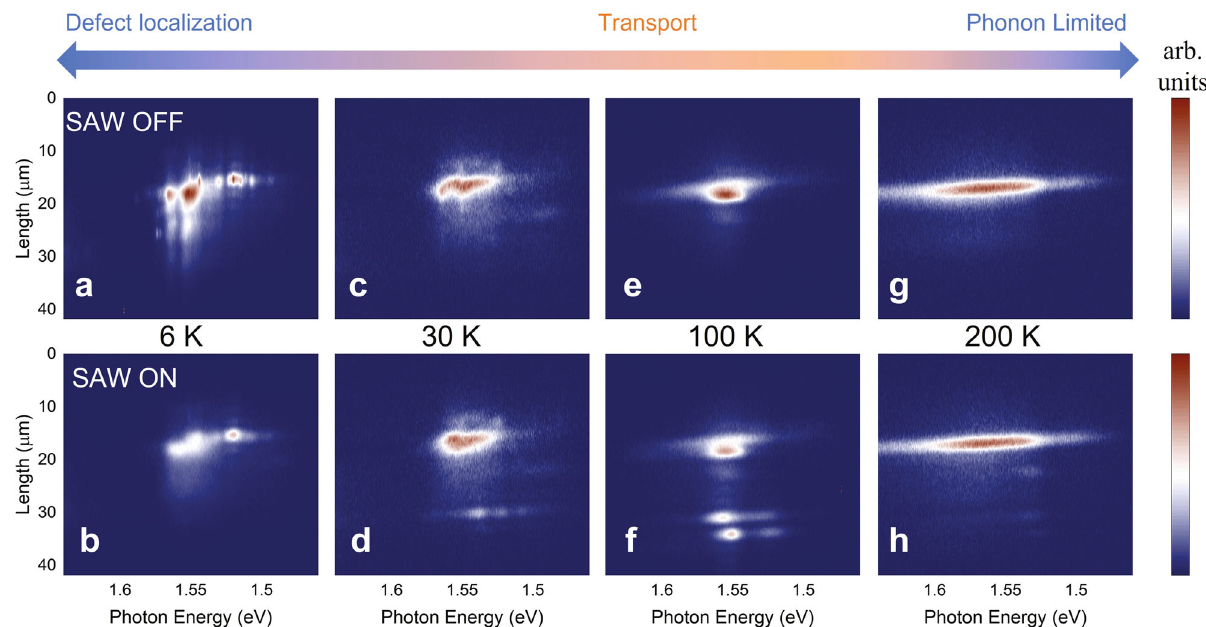
Fig. 4 SAW-driven IX transport at varying temperatures. The spectral PL image of exciton transport at 6-200 K with SAW off ( a , c , e , g ) and on ( b , d , f , h ). For clarity, the data at each temperature is normalized separately. a , b At low temperature (6 K), IXs show narrow peaks as they are highly localized to recombination centers such as defects or couple strongly to local vibrational modes. SAW can delocalize the IXs so to suppress the emission. However, the transported IXs remain dark because of the reduced phonon-assisted recombination at low temperature. c , d At elevated temperatures (30 K), the IXs are thermalized with broad emission. SAW transport turns on with visible emission at the fl ake edge. e , f At 100 K, SAW transport of IXs is most prominent as IXs have a suf fi ciently long lifetime and are less susceptible to defect trapping. g , h At even higher temperatures, SAW transport, although still visible, is inef fi cient as exciton-phonon scattering dominates and the IX population lifetime is